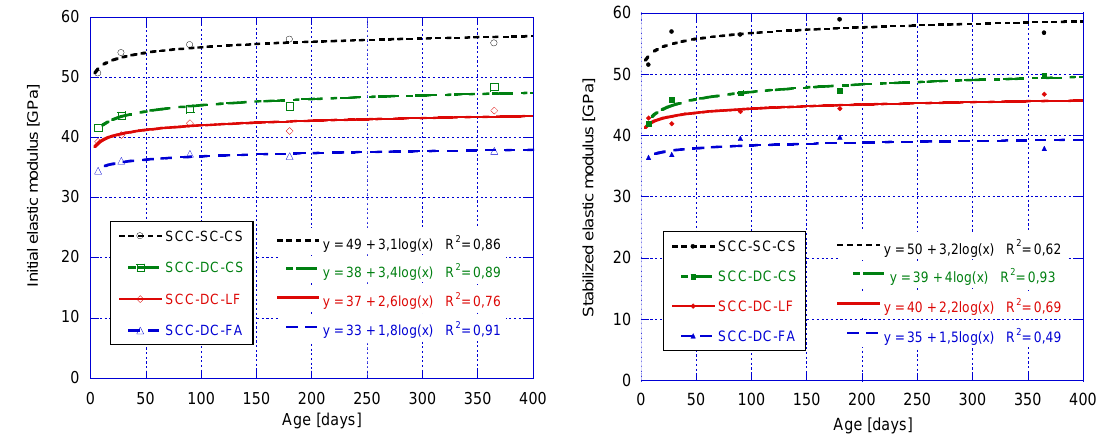
Figure 8. Evolution of the initial elastic modulus ( left ) and the stabilized elastic modulus ( right ) for the different concrete mixes.